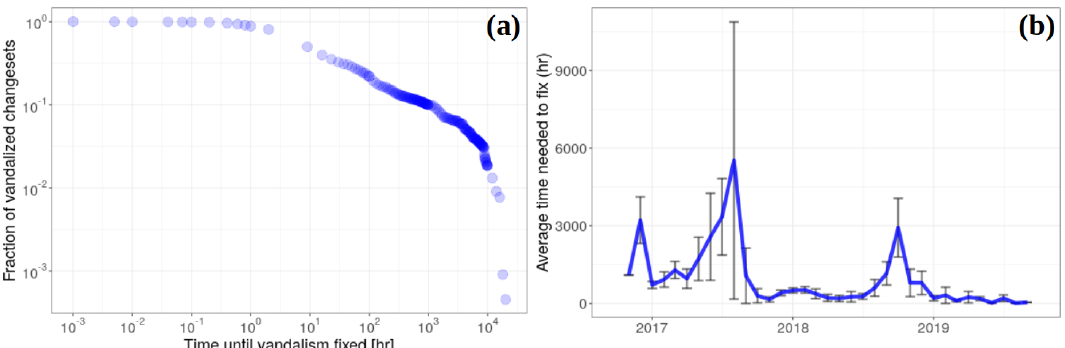
Figure 7. Temporal characteristics of vandalism fixes; ( a ) complementary cumulative distribution of time taken by the community to fix each vandalism on a log-log plot, and ( b ) average time required to fix vandalism submitted each month showing a decreasing trend. Standard errors are represented as error bars.